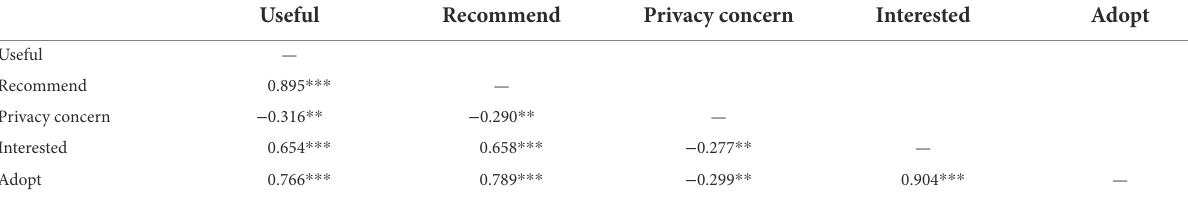
TABLE 2 Relations among 5 primary